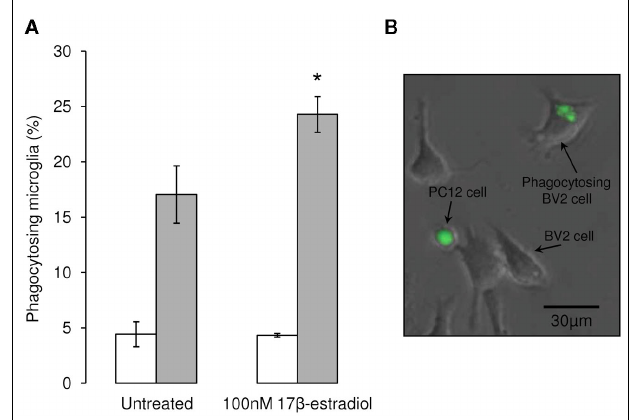
FIGURE 4 | Estradiol enhances microglial phagocytosis. We used our established in vitro model of co-cultures of the murine microglial cell line BV2 and the rat neuron-like cell line PC12 to investigate phagocytosis, for full details see (McArthur et al., 2010), to study the effects of estradiol treatment upon the removal of apoptotic neurons. (A) Treatment of BV2 microglia for 16h with 100nM 17 β -estradiol had no effect upon the phagocytosis of vehicle-treated, non-apoptotic PC12 cells ( (cid:2) ), but significantly increased the number of microglia actively phagocytosing apoptotic, 6-OHDA-treated PC12 cells ( (cid:3) ) when compared with untreated control microglia, ∗ p < 0.05 vs. untreated microglia. (B) Typical example of BV2 microglia phagocytosing CMFDA-labeled, green fluorescent PC12 cells after 6-hydroxydopamine